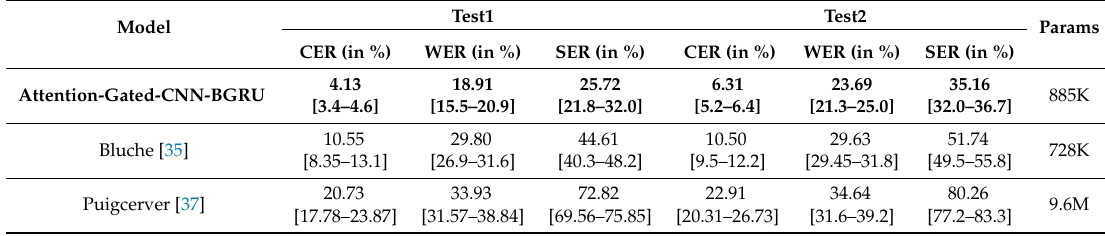
Table 1. Comparison of results on HKR dataset to previous